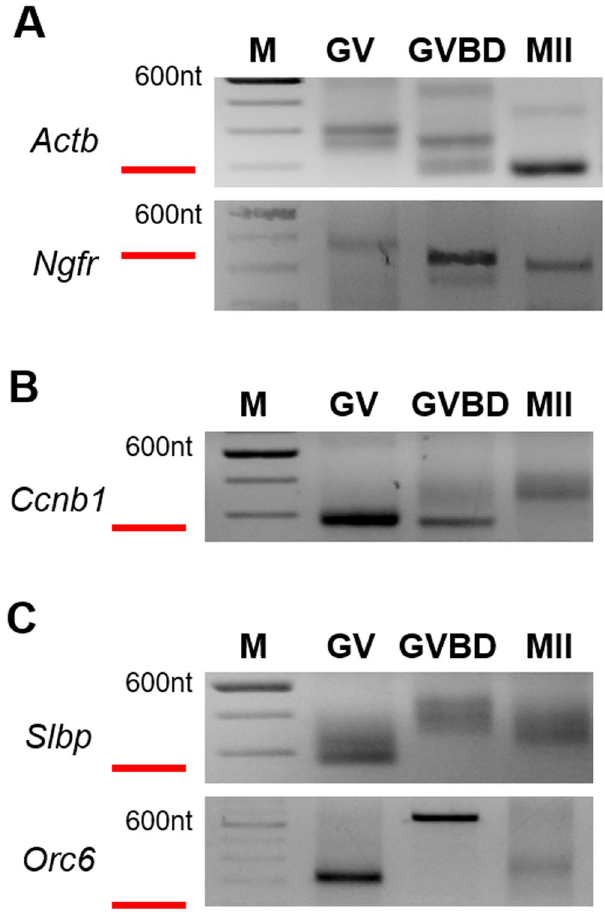
Figure 1. Patterns of mRNA polyadenylation during oocyte meiotic maturation. Immature oocytes containing an intact germinal vesicle (GV) were obtained from antral follicles and collected immediately (GV), or allowed to mature for 6 hr (germinal vesicle breakdown, GVBD) or 12–15 hr (metaphase II, MII). Poly(A) tail length of the indicated mRNAs was analyzed used the RL-PAT technique. Red bars indicate the product length that would be generated using a non-adenylated mRNA. Molecular weight markers (100 bp ladder) are shown in left-most lane. ( A ) Actb and Ngfr become progressively deadenylated. ( B ) Ccnb1 becomes progressively polyadenylated. ( C ) Slbp and Orc6 become polyadenylated and subsequently